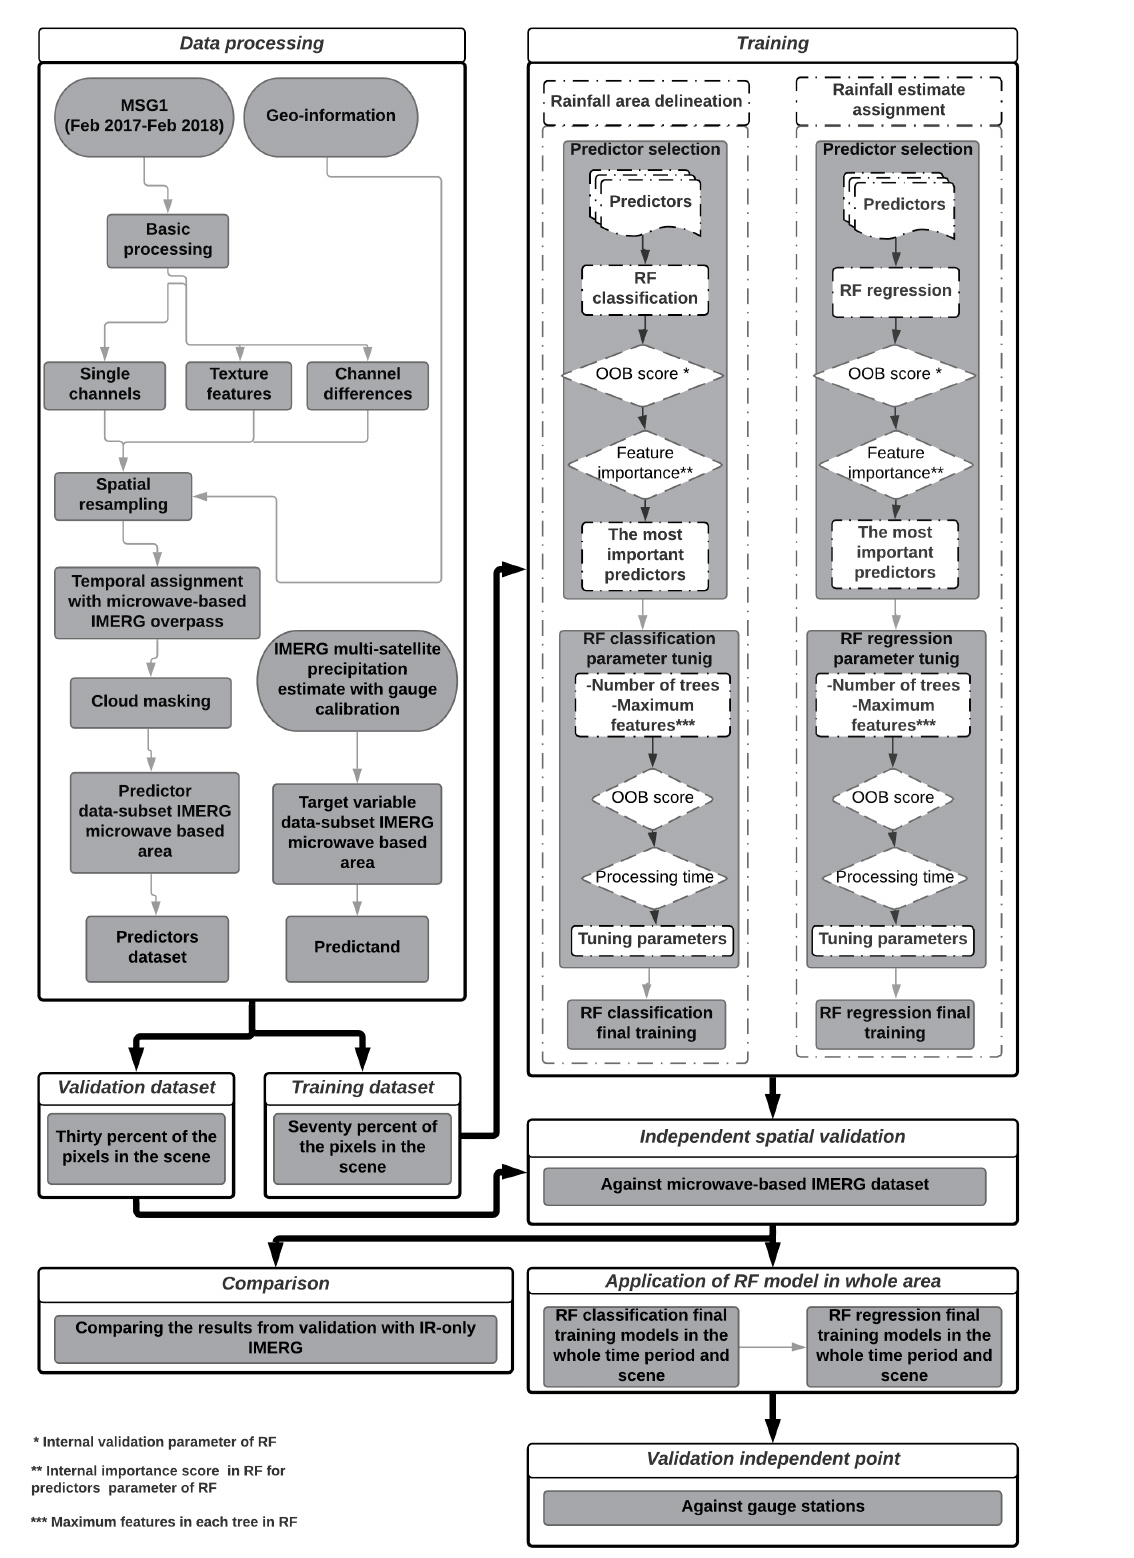
Figure 1. Schematic view of the rainfall retrieval workflow. IMERG: Integrated Multi-SatEllite Retrieval; MSG: Meteosat Second Generation; OOB: out-of-bag; RF: random